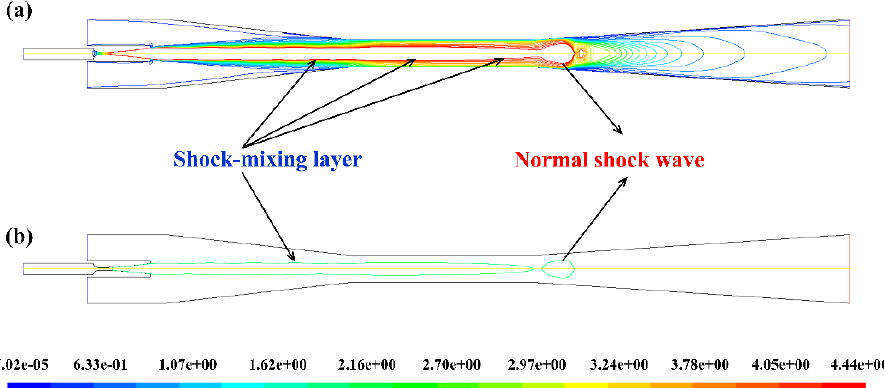
Figure 7. The location and range of the shock-mixing layer ( a ) the contour of Mach number ( b ) the